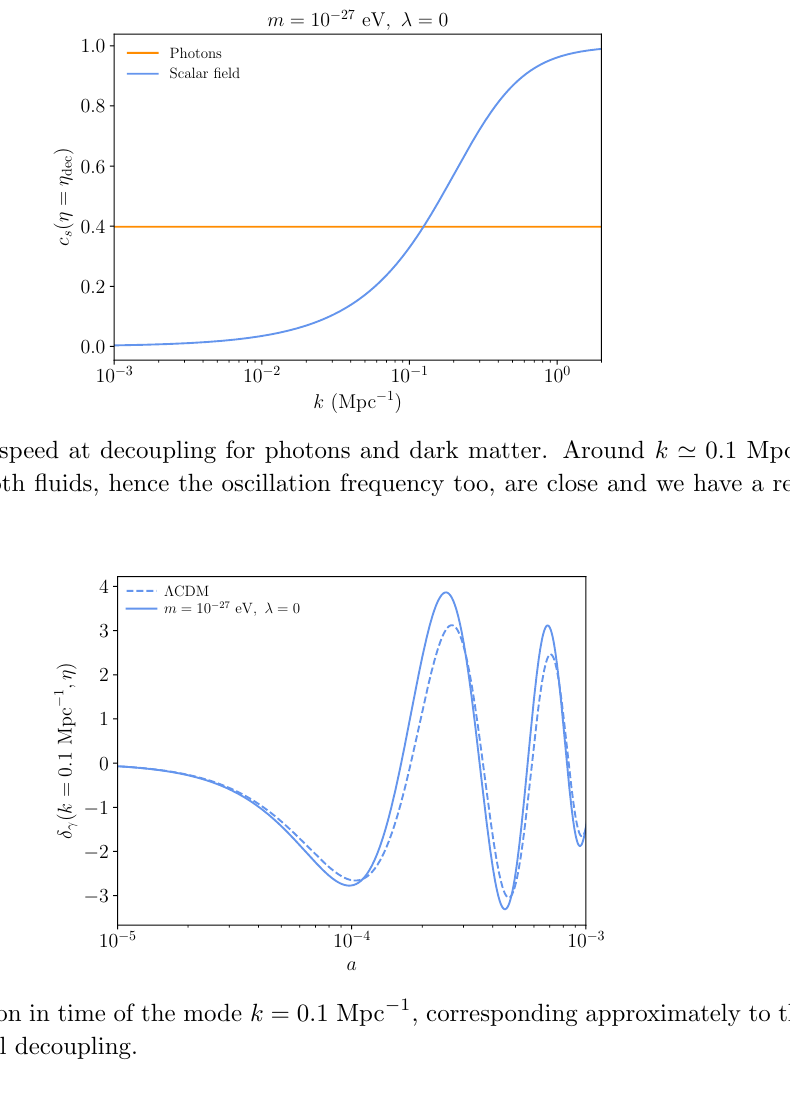
Figure 6 . Evolution in time of the mode k = 0 : 1 Mpc (cid:0) 1 , corresponding approximately to the (cid:12)fth acoustic peak, until